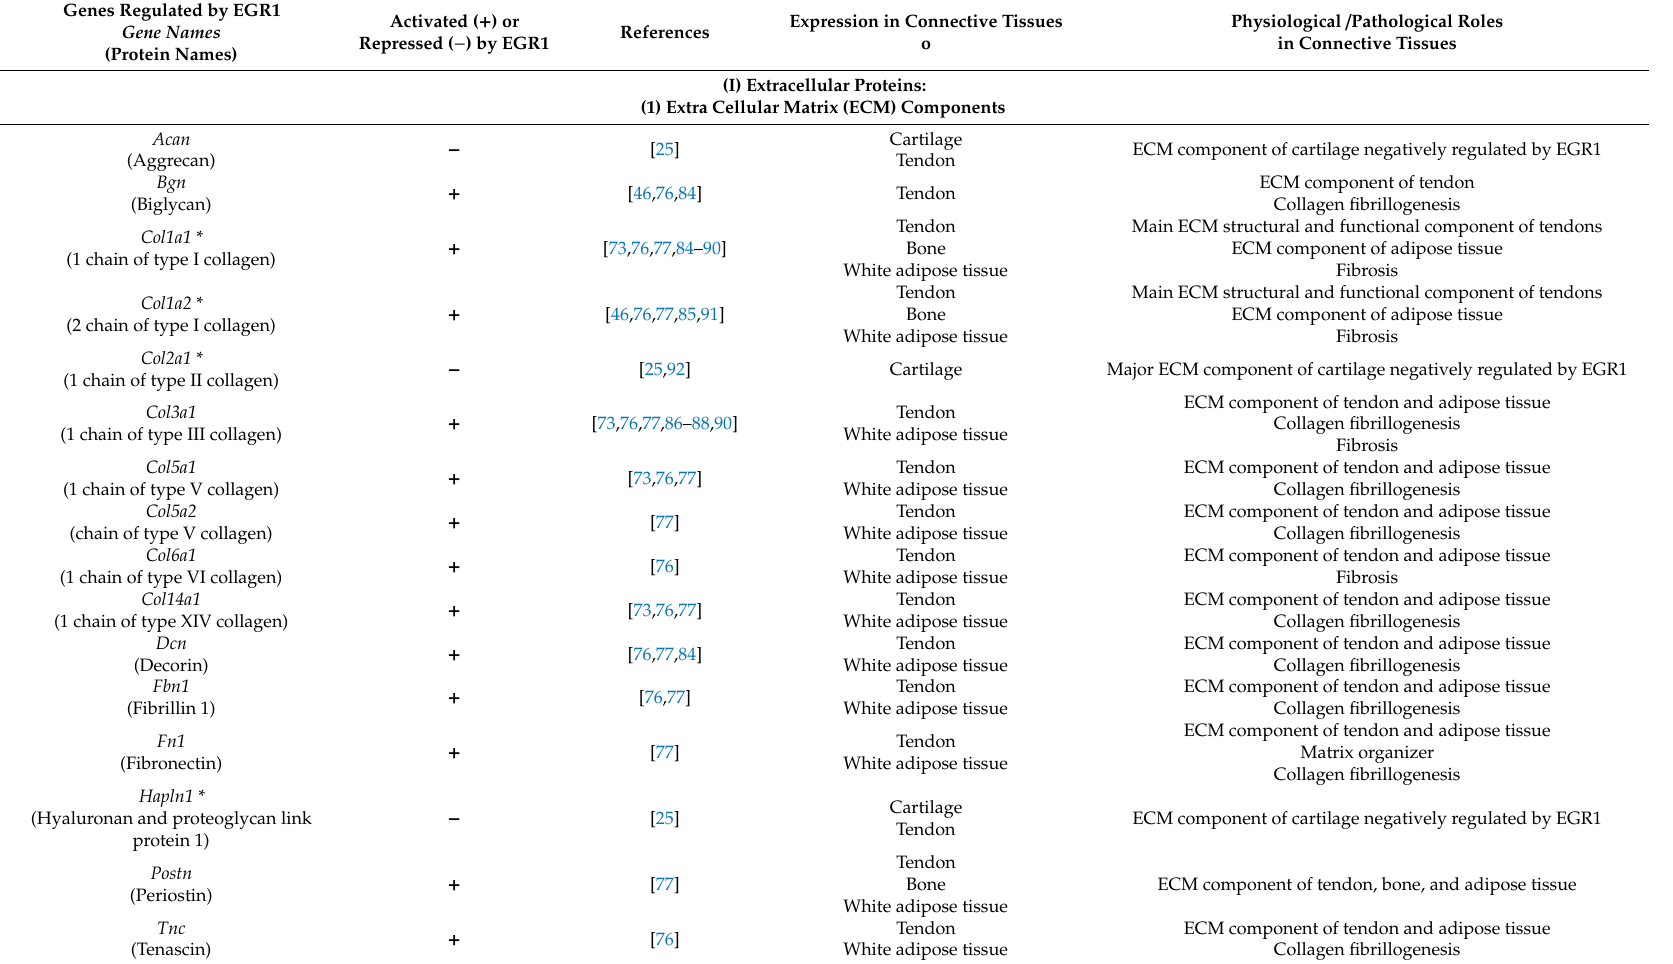
Table 1. List of genes regulated by EGR1 in three connective tissues: tendon, bone, and adipose